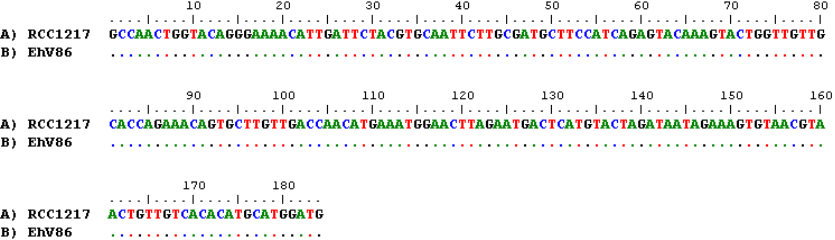
Figure 5. Pairwise nucleotide sequence alignment of a 180 bp fragment of the viral helicase gene (ehv430) amplified using RT-PCR from RCC1217 (1N) aligned with the helicase gene from EhV-86. Dots represent positions where the same nucleotides are present as in the top sequence, and letters represent nucleotide substitutions.